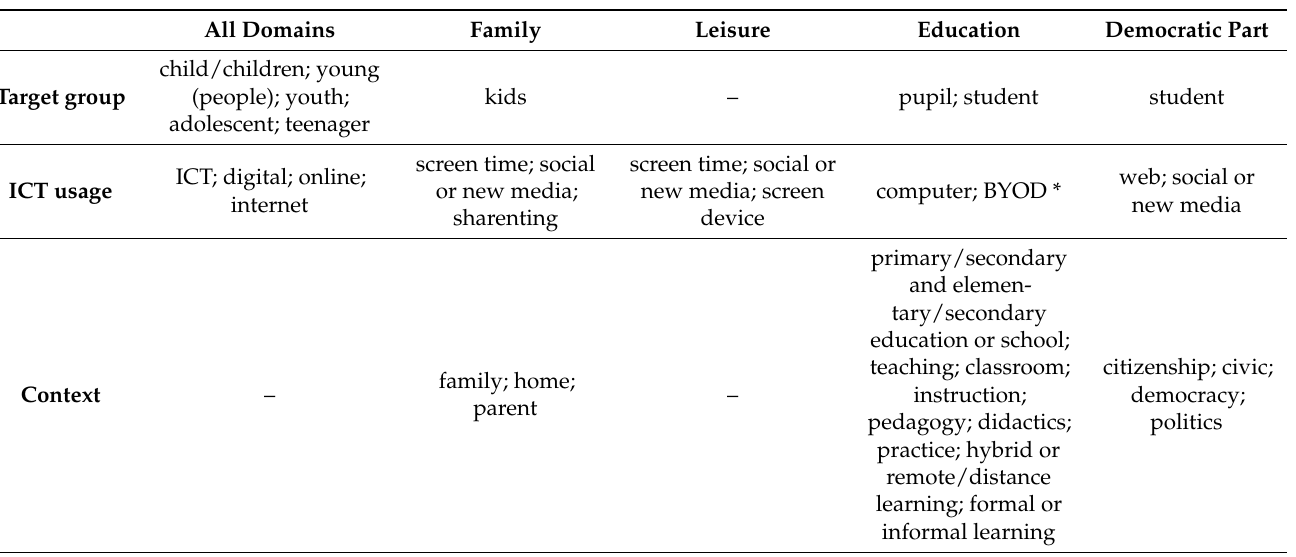
Table 1. Identification of the keywords across four domains of children’s and young people’s ICT use in their everyday